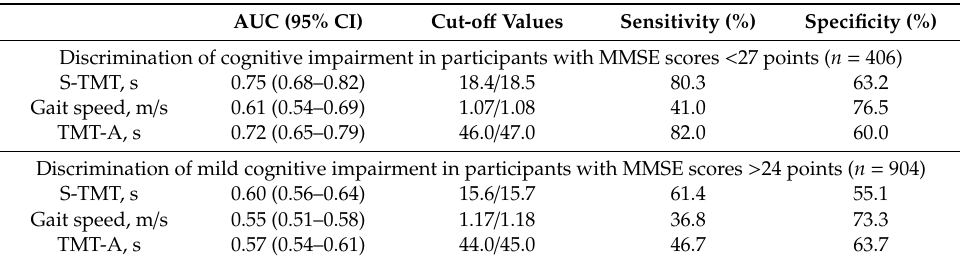
Table 2. Discrimination performance and cut-o ff values of the S-TMT, gait speed, and TMT-A for cognitive impairment and mild cognitive impairment screening.